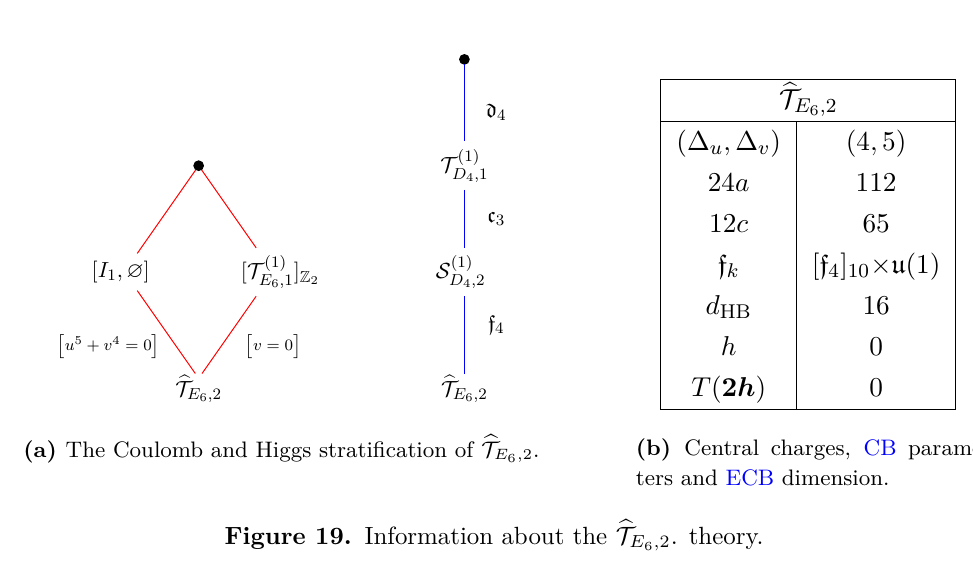
Figure 19. Information about the b T E